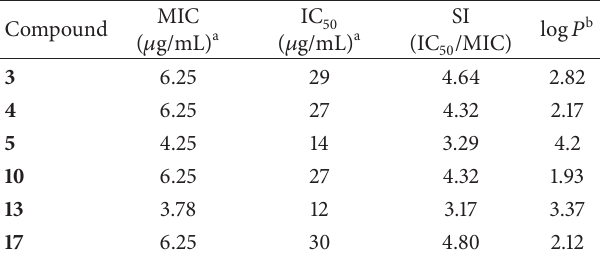
Table 2: Results of second level antituberculosis